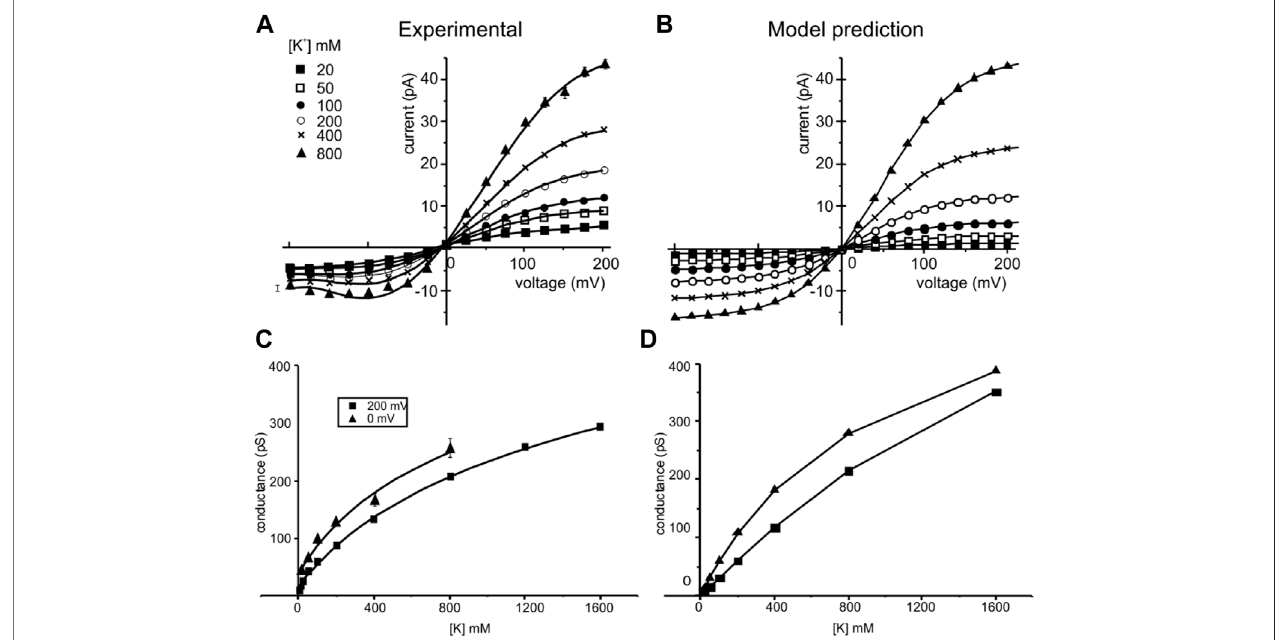
FIGURE 6 | Experimental and simulated current-voltage (IV) and conductance-concentration plots. Left : experimental IV relationships (top) of the KcsA channels taken at different symmetrical K + concentrations (indicated) and conductance-concentration relationships (bottom) at two membrane potentials. Data are from LeMasurier et al. (2001). Right: IV and conductance-concentration relationships predicted by our model using the kinetic scheme of Figure 4 and rate constants adjusted for microscopic reversibility in Table 1 . The conditions used in our modeling were the same as those used to obtain the experimental results.